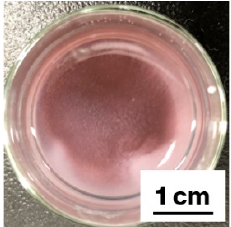
Figure 2. Photograph of Cu–P25–ASP.